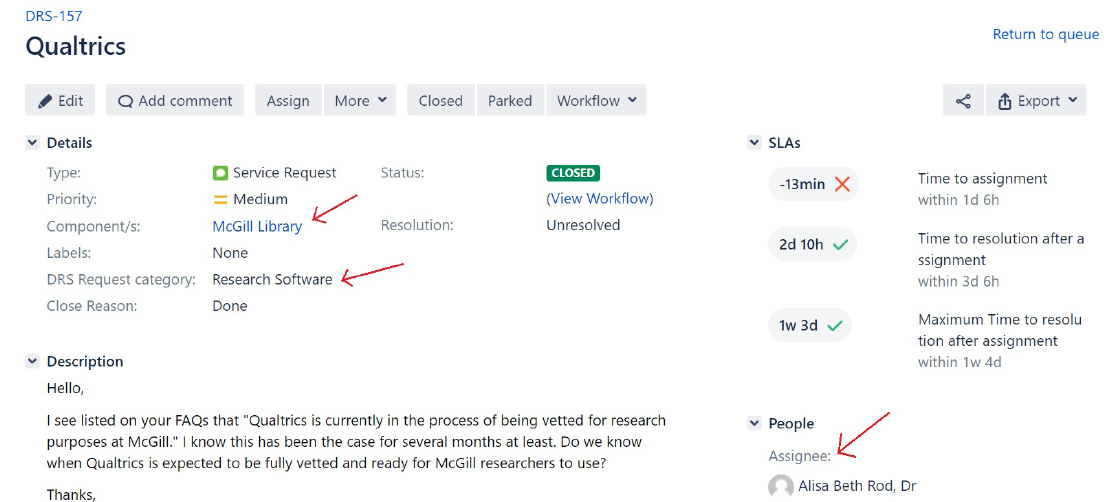
Figure 2 : Digital Research Services Jira Service Desk Example Ticket and Metadata. Red arrows point to the assignee of the ticket, the request category, and the faculty/department of the requester (McGill Library in this case). Note: this image has been cropped for privacy